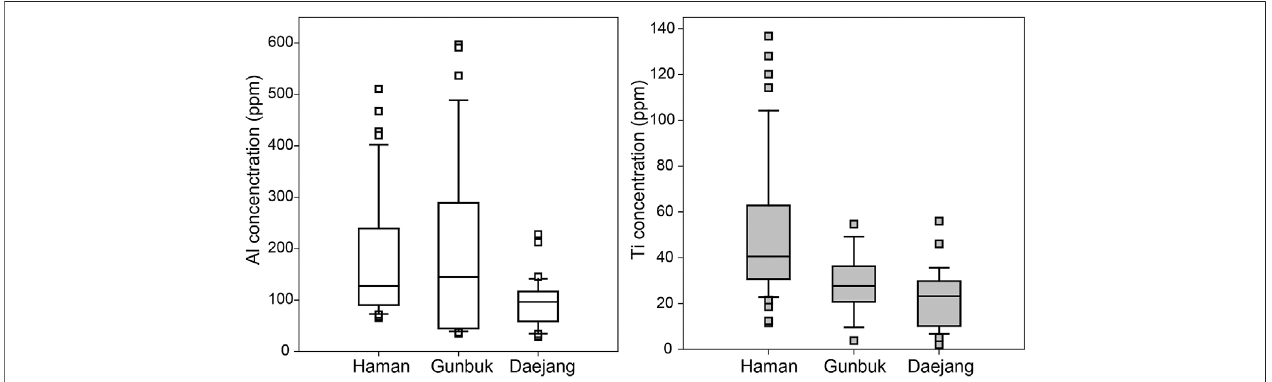
FIGURE 12 | Concentrations and ranges for (A) Al and (B) Ti concentrations in the quartz veins of the Haman, Gunbuk, and Daejang deposits. Ranges of Al concentrations in the Haman and Gunbuk deposits overlapped, and ranges of Ti concentrations in the Gunbuk and Daejang deposits also overlapped.